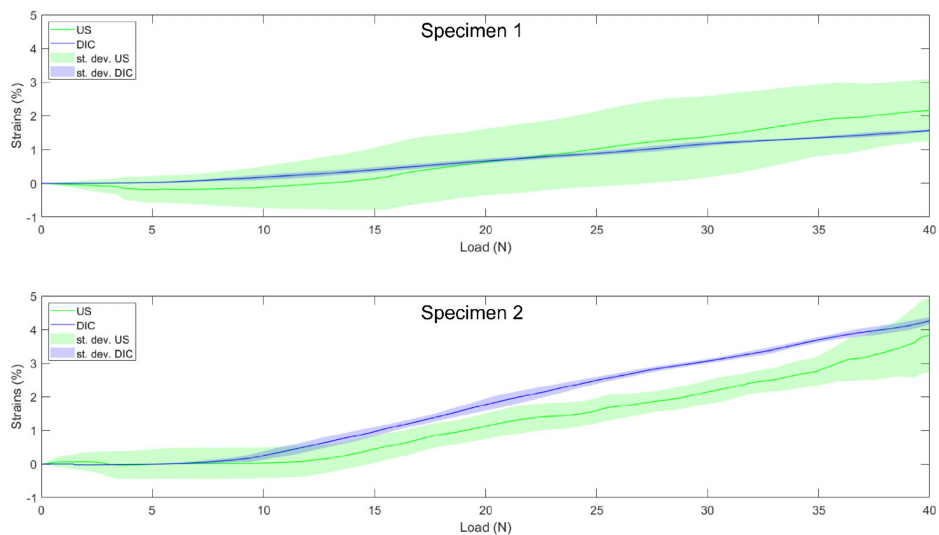
Figure 7. Individual load–strain curves for the two valid lateral collateral ligaments from the “validation” group, from 0 to 40 N. Solid lines represent the US (green) and DIC (blue) load–strain curves. Shaded areas represent the standard deviation across the trials of each specimen for US (green) and DIC